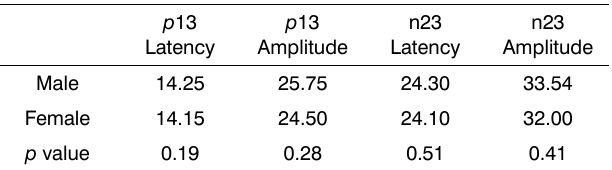
Table 3. Comparison of P13 and N23 latencies (ms) and P13- N23 wave amplitude (µV) between